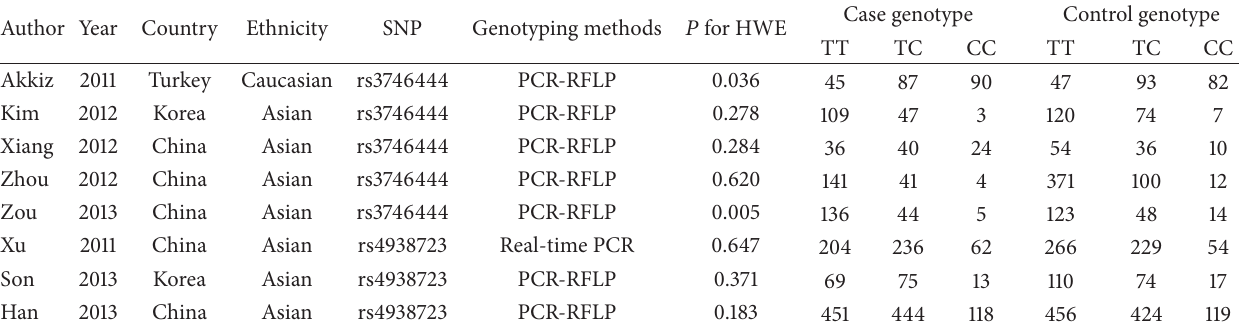
Table 1: Characteristics of included studies.